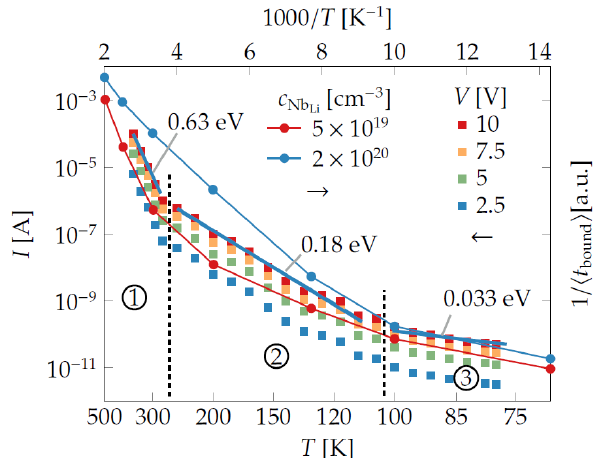
Figure 5. Temperature dependence of the current for thin-film LNO. Measured current at different voltages from 360 K to 77 K. We can observe different regimes of thermal activation ① above 300 K with Ea = 0.63 eV, at ② between 300 K and 100 K with E a = 0.18 eV and ③ below 100 K with a thermal activation of Ea = 0.03 eV. These are overlaid with the inverse bound polaron lifetime, as calculated by Monte Carlo (MC) simulations.